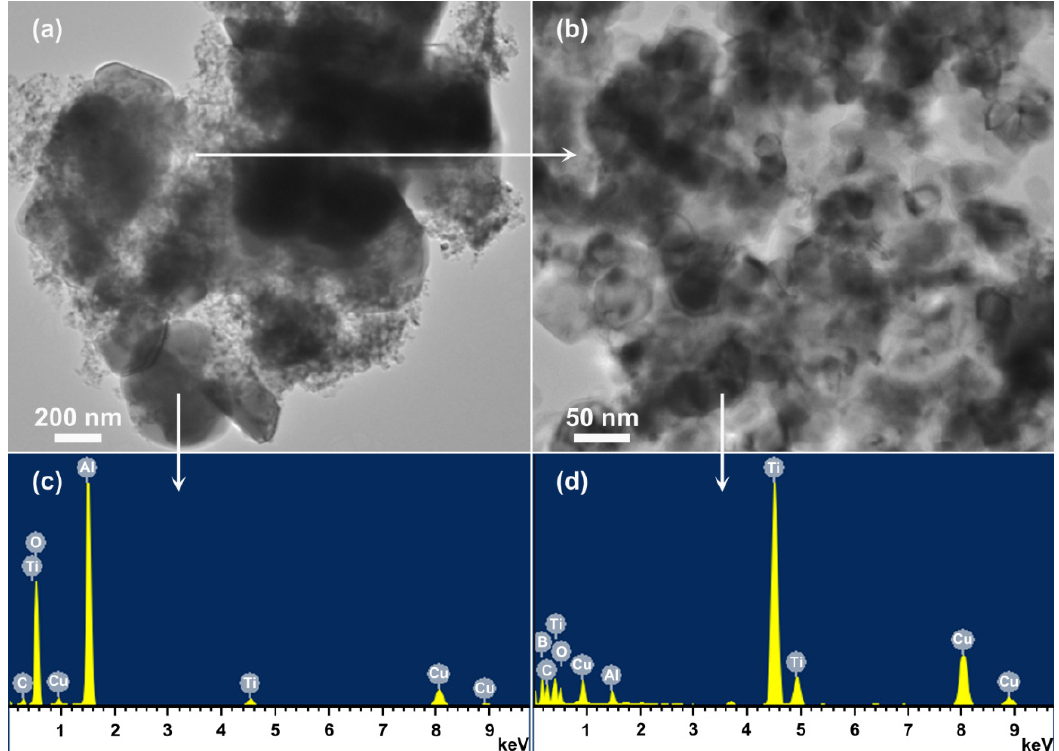
Figure 7. TEM images ( a , b ) and corresponding EDS ( c , d ) of the Al 2 O 3 -TiB 2 composite powder resultant from 5 h firing in NaCl at 1050 °C (the small C and Cu peaks arose from the carbon coating and the Cu grid).